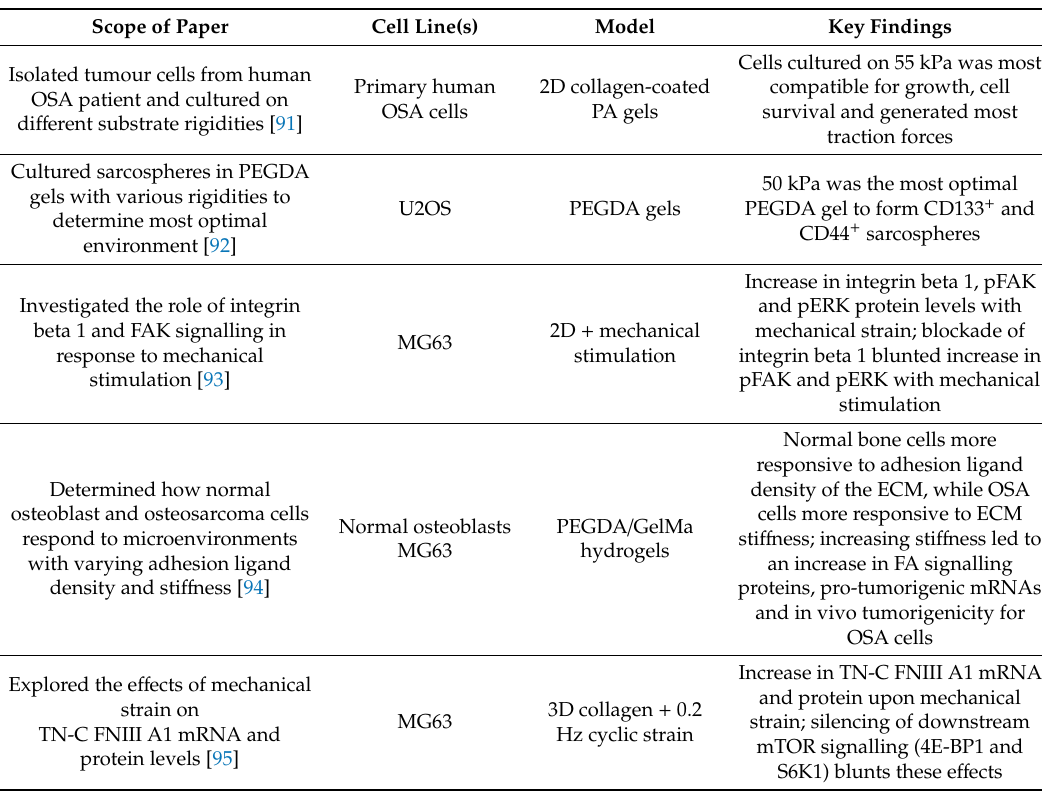
Table 2. Summary of the literature included in this review on how Ewing sarcoma and OSA cells respond to mechanical